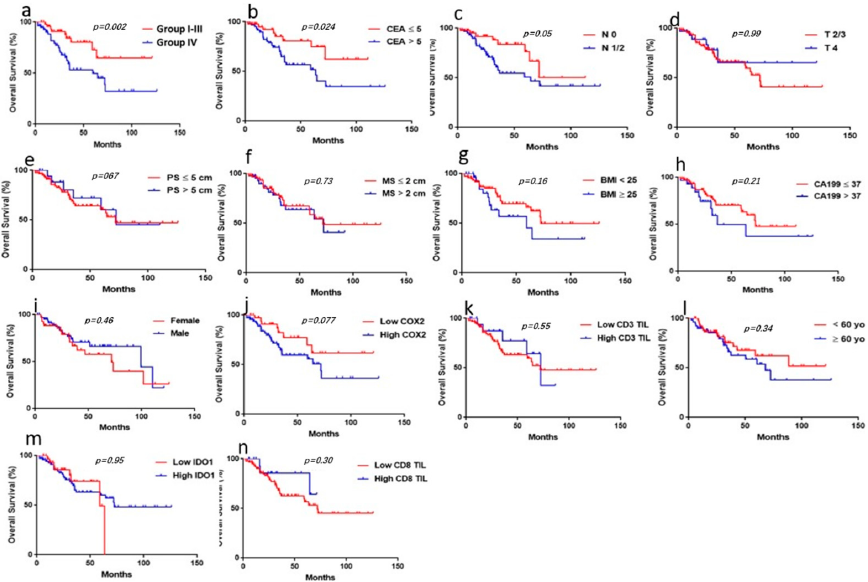
3.3. Univariate Analysis of the Correlation of Clinicopathological Parameters with OS To confirm the effect of traditional clinicopathological parameters on OS in patients with liver oligometastases of colorectal cancer, we performed a univariate analysis of traditional clinicopathological parameters for prognosis. The results reveal that N stage (1/2 vs. 0) ( p = 0.050) and CEA level (ng/mL) (>5 vs. ≤ 5) ( p = 0.024) were significantly correlated with OS in patients with liver oligometastases of colorectal cancer (Figure 2b,c). We observed other clinicopathological parameters, such as gender, age, BMI, T stage, tumor size, liver metastasis size, CA19-9, CD3 TILs, and CD8 TILs, which were not significantly correlated with OS in patients with liver metastases of colorectal cancer (Figure 2d–n). We found that IDO1/COX2 coexpression (Group IV vs. Group I/II/III), as opposed to IDO1 or COX2 coexpressions alone, was significantly correlated with OS ( p = 0.002) (Figure 2a).